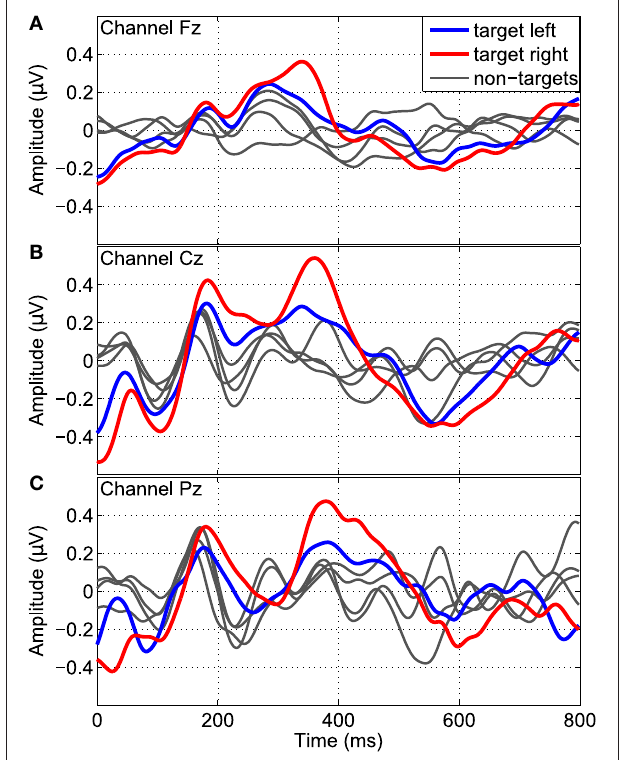
FIGURE 8 | P300 response evoked by twitches randomly embedded into the stream of repetitive stimuli. Grand average time segments (0–800ms) after twitch onsets over all subjects are shown for the channels Fz, Cz, and Pz (A–C) . Separate segments are shown for left (bold blue) and right (bold red) target twitches, as well as for all remaining non-target conditions